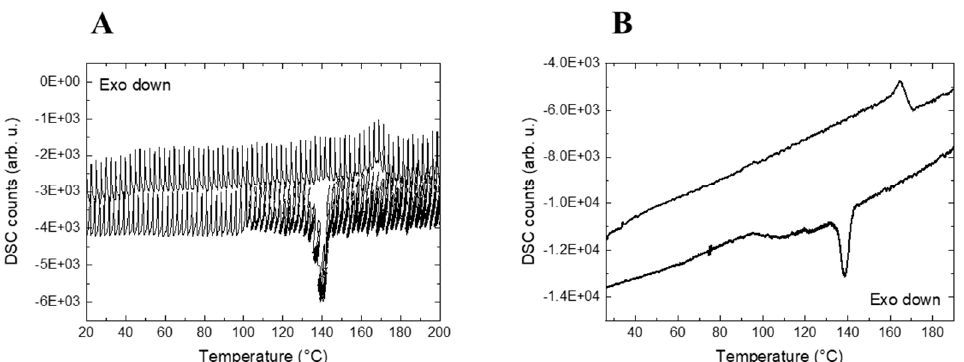
Figure 2. Linkam DSC profile of the cooling and second heating ramps of the PVDF sample during the simultaneous SAXS/WAXS coupled to the Linkam DSC combined with the Raman spectrometer with the activated laser shutter ( A ) and with the deactivated laser shutter ( B ).